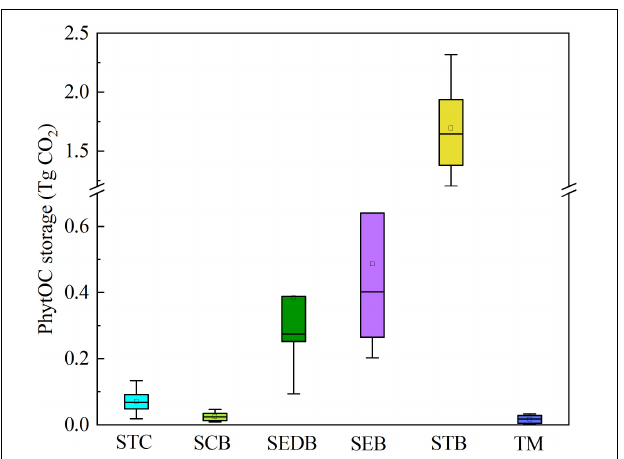
FIGURE 2 | PhytOC storages of forest litter layers in different forest types.